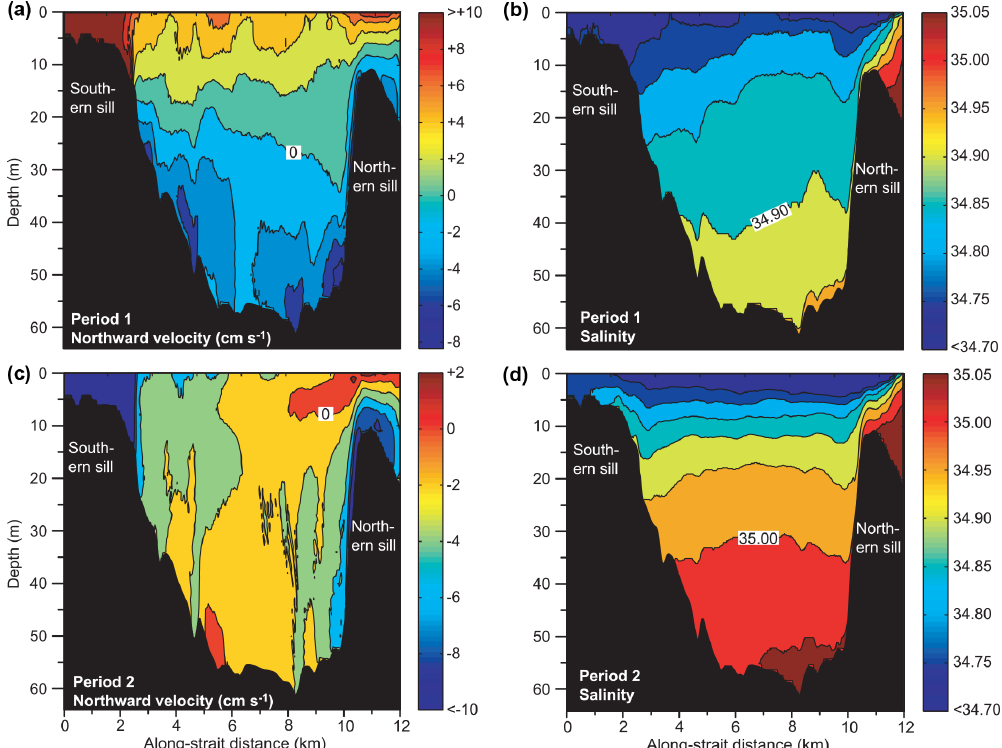
Figure 8. Cross-estuary averaged northward velocity and salinity plotted against along-strait distance for the two different periods defined in Fig. 7. For velocity, the most positive (a) or negative (c) values are grouped together. Note different velocity scales. For salinity, the lowest values are grouped together. The bottom depth indicated by the black areas is the maximum depth along each section crossing the estuary.